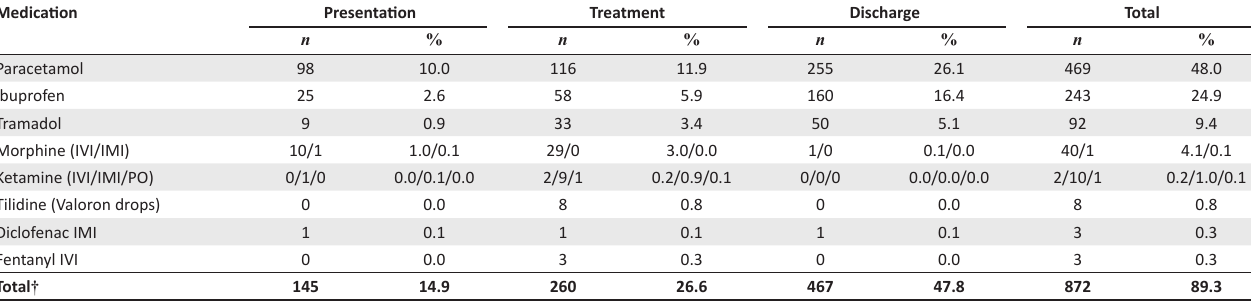
TABLE 3: Prescribed analgesia within the continuum of care in the EC. Medication Presentation